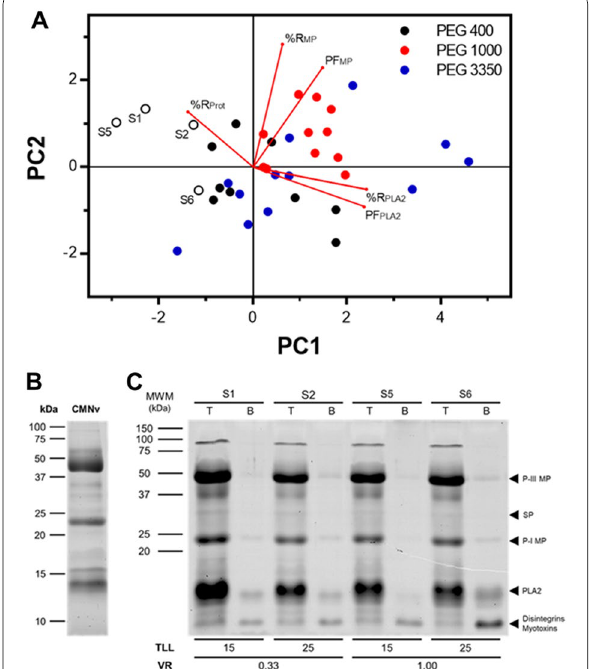
Fig. 1 Effect of PEG–potassium phosphate systems’ variables on the recovery of MPs and PLA 2 . A Principal component analysis (PCA) of the recovery of MPs and PLA 2 in systems with a PEG molecular weight of 400, 1000 and 3350 g mol − 1 , TLL 15, 25, 35 and 45% w/w and V R 0.33, 1 and 3. Clear circles ( ○ ) denote the selected systems with the best partition characteristics. B SDS‑PAGE of 15 μg of C. m. nigrescens venom (CMNv) and molecular weight marker (MWM). C SDS‑PAGE of top and bottom phases (T and B, respectively) of selected ATPS from PCA analysis